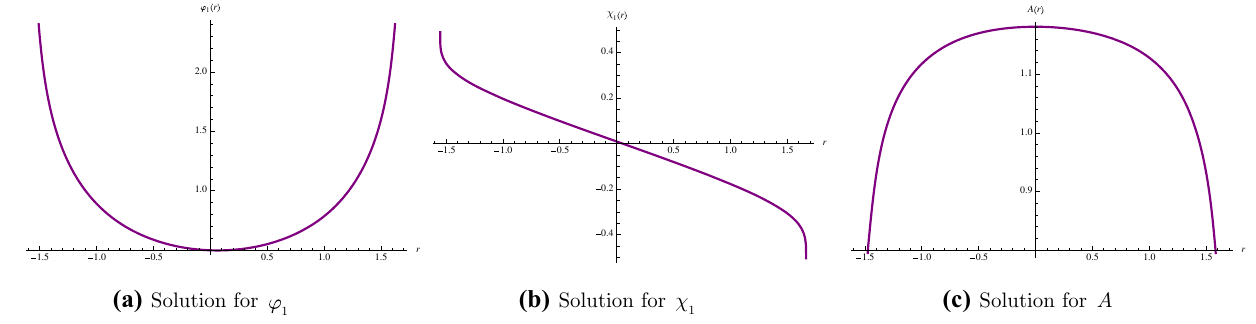
Fig. 4 N = 1 Janus solution from type IIB compactification within a truncation to ϕ 1 and χ 1 with κ = λ = (cid:21) =